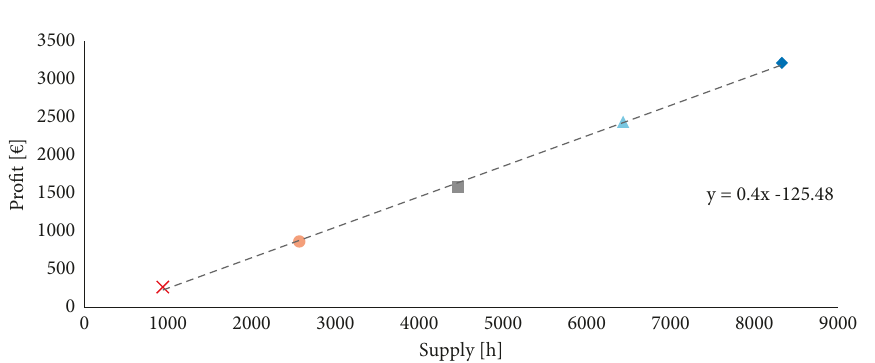
Figure 10: Linear regression of the profit in function of the